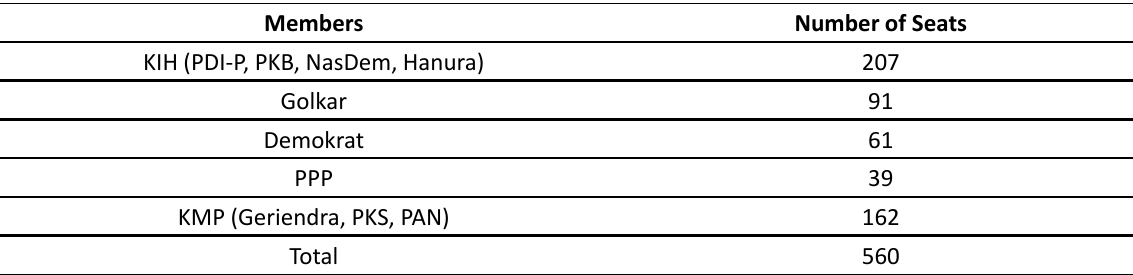
Table 1: Number of Seats in the Parliament of 2014-2019